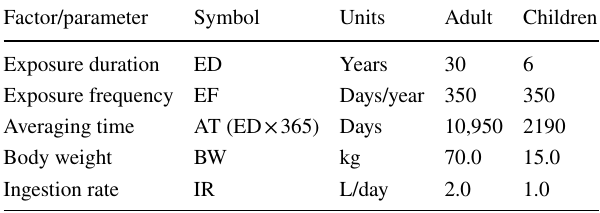
Table 1 Input parameters to characterize CDI